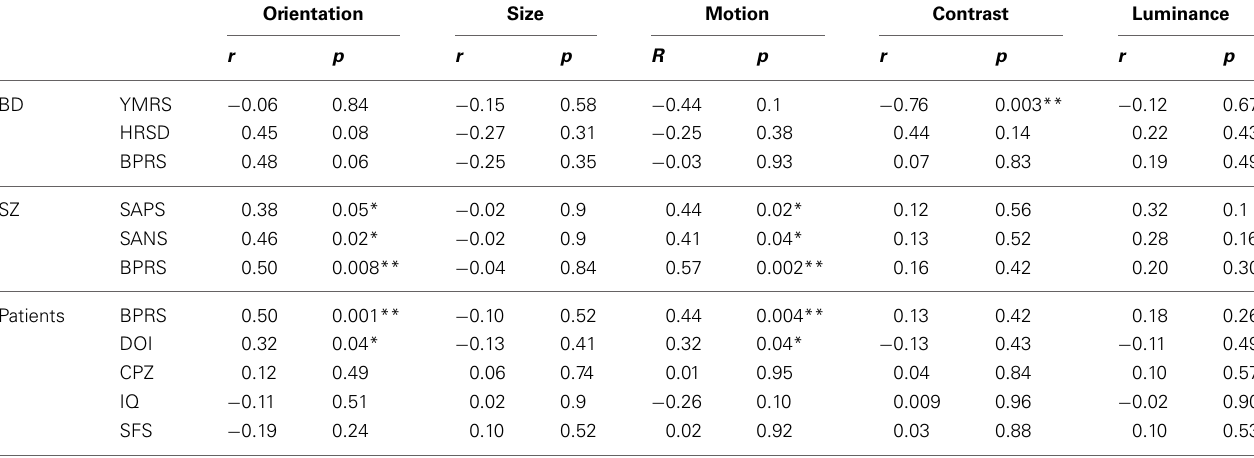
Table 5 | Correlations between context measures and clinical and demographic